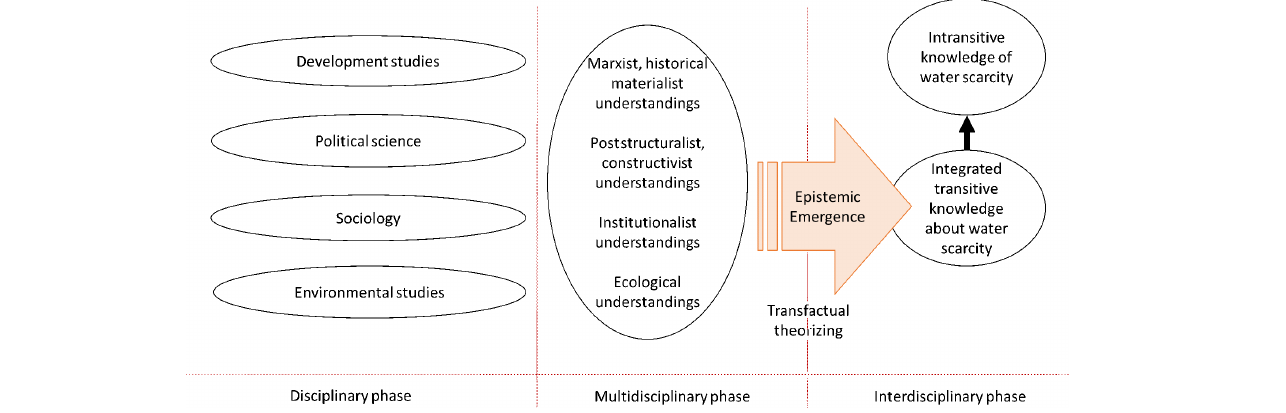
Fig. 3 . Process of interdisciplinarity in relation to water research in LUCID. Adopted from (Bhaskar et al. 2017, reproduced by permission of Tayor & Francis Books